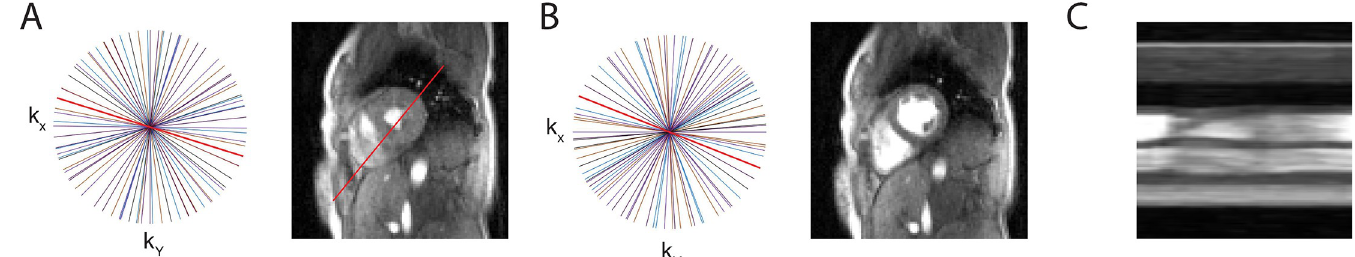
Fig 2. Closed-loop radial sampling of scanning in a healthy volunteer. Distribution of radial views and corresponding 2D real-time short axis images of closed-loop sampling at A) end-systole and B) end-diastole. Adaptive sampling results in near uniform radial distribution of views and thus high image quality. C) Cardiac motion is shown via projection through the left